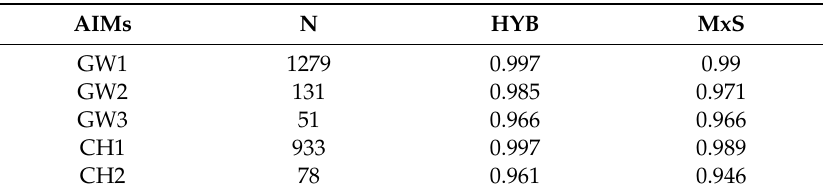
Table 2. Coefficient of determination values (r 2 ) calculated between the ancestry percentages using the full set of SNPs and the AIM panels in the simulated (HYB) and case study (MxS) populations. N is the number of SNPs in each panel.